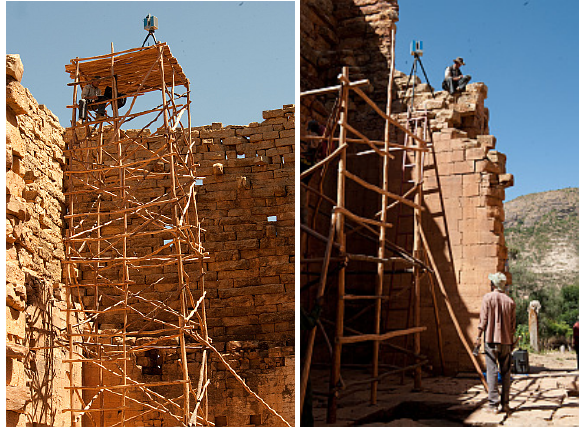
Figure 2: Scanning on scaffolding (left) and on top of the wall (right) using the IMAGER 5006 from Zoller + Fröhlich The scanning resolution was set to “high” (6.3mm@10m), which amounts to 25GB of data per scan. For the colouring of